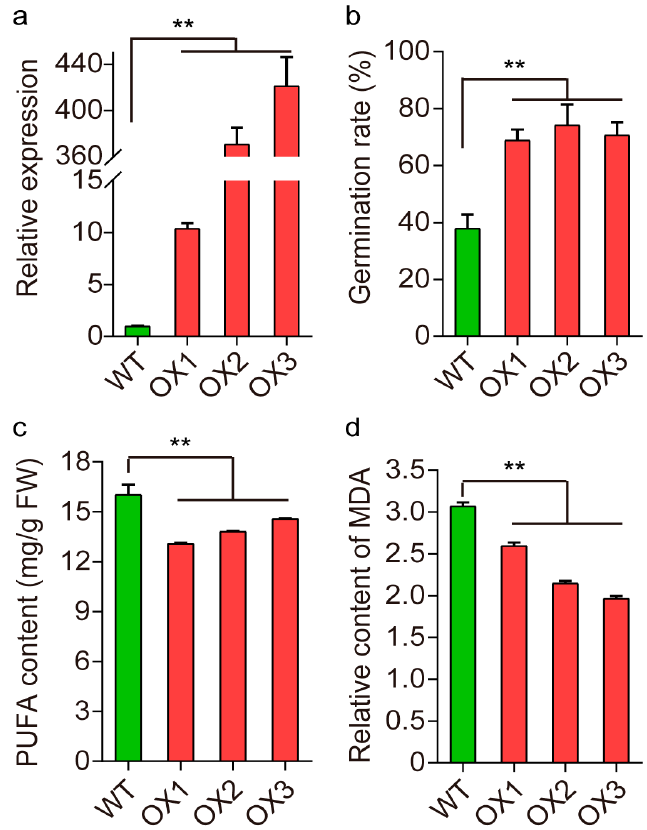
Figure 5. Germination behaviors of the transgenic lines overexpressing OsFAH2 ( a ) Relative expression levels. ( b ) Germination rates after artificial aging. ( c ) Polyunsaturated fatty acid (PUFA) contents. ( d ) malondialdehyde (MDA) contents among the overexpression lines (OX1, OX2, OX3) and wild type (WT). Error bar represents mean ± SE with three to six replicates. Double asterisks indicate significant di ff erence compared with WT at p <